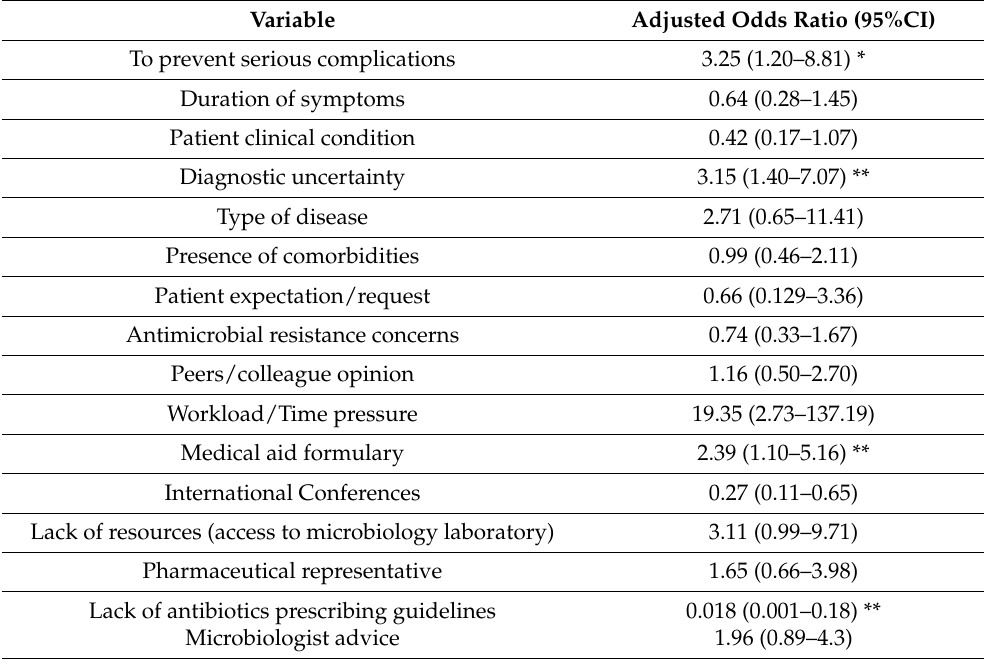
Table 4. Designated Environmental Factors Associated with Empiric Antibiotic Prescribing and Adjusted Odds